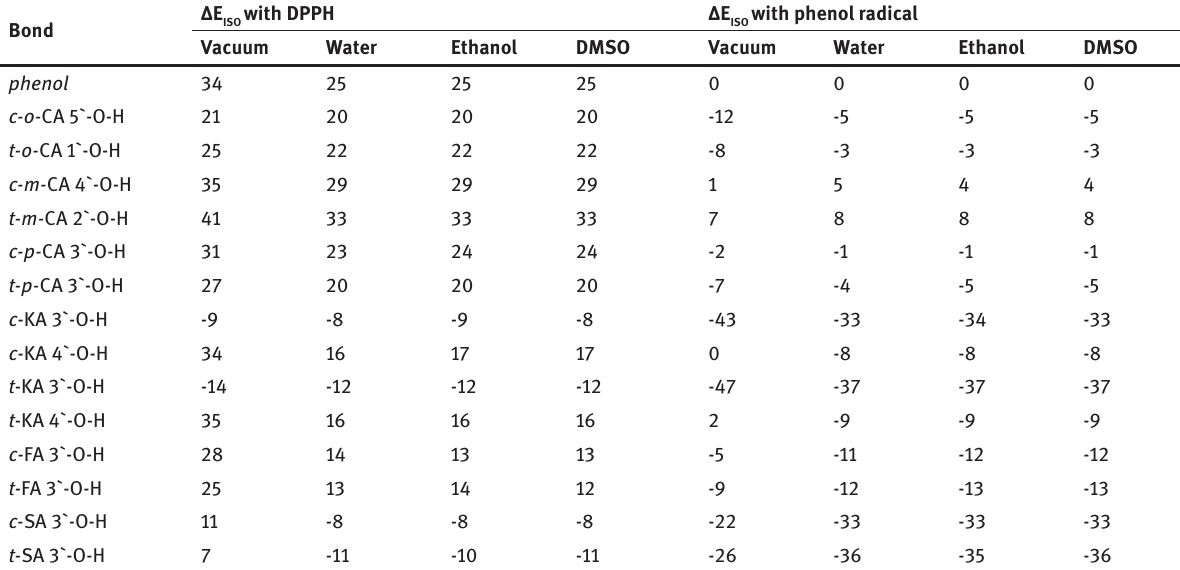
in [kJ mol -1 ] calculated with B3LYP/6-311++G(2d,2p) in vacuum, water, ethanol and Table 9: ∆E ISO